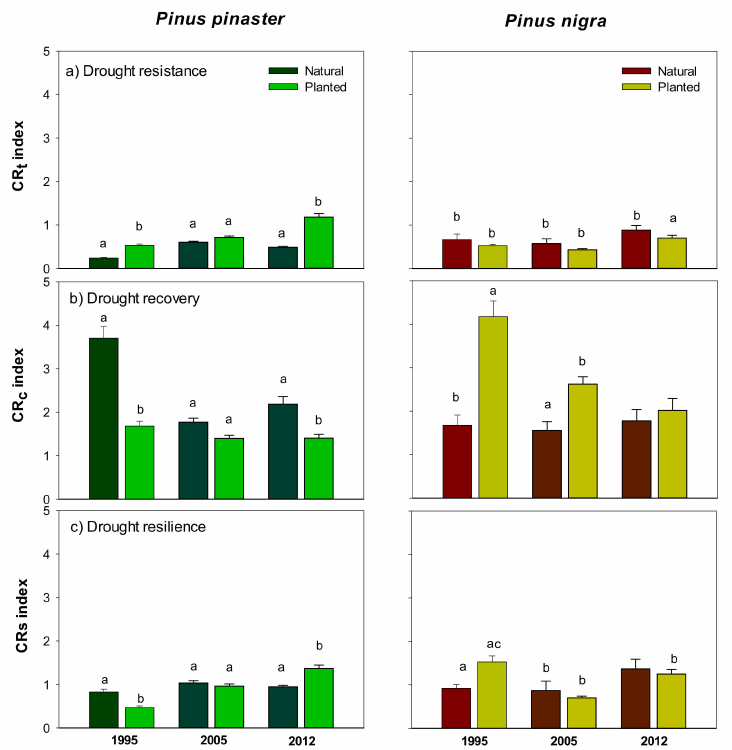
Figure 3. Resistance (CR T ), recovery (CR C ), and resilience (CR S ) growth indices calculated for Pinus pinaster and P. nigra natural and planted stands during three dry years (1995, 2005 and 2012). Values are means ± standard error and different letters (a, b and c) indicate significant differences ( p < 0.05) between stand type within drought events. Bold values show significant differences among groups (Student’s t -test, significance levels: * p ≤ 0.05; ** p ≤ 0.01; *** p ≤